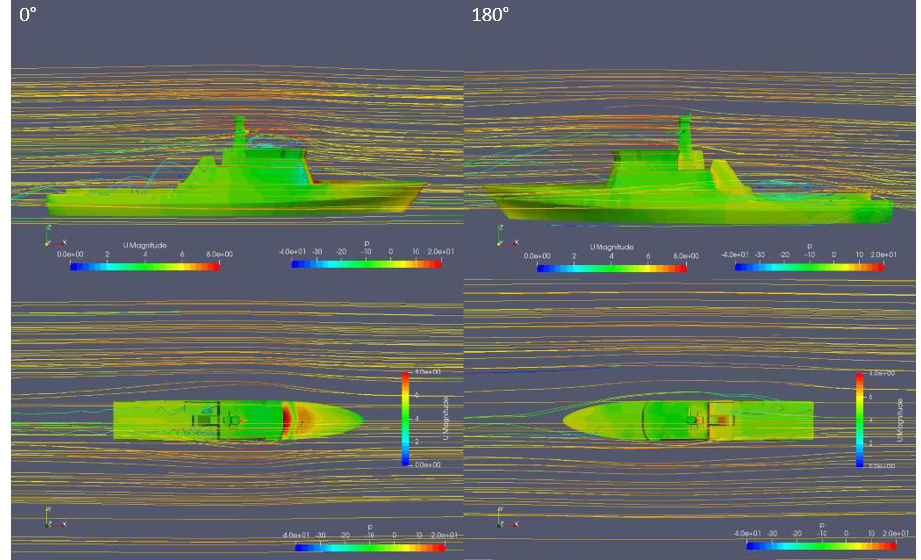
Figure 9. Free stream velocity and pressure distribution on the hull (above the waterline), left for headwind and right for the following wind (velocity scale: 0 to 8; Pr. scale: −40 to 20), after reaching the steady-state.